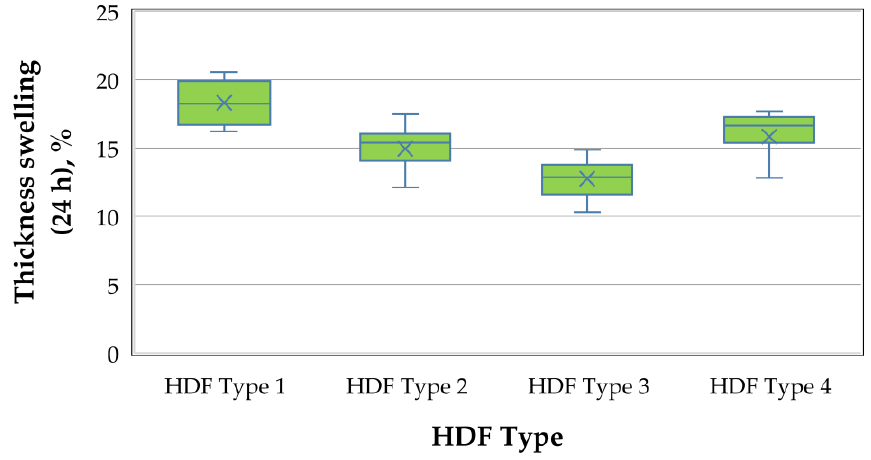
Figure 3. Thickness swelling of HDF panels produced.